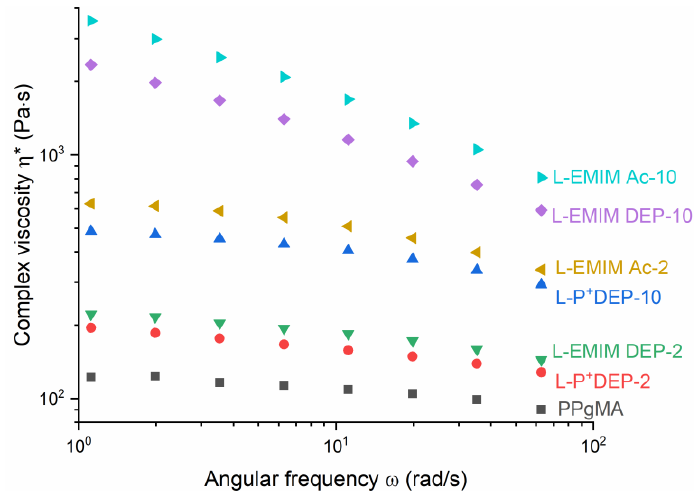
Figure 6. Complex viscosity of neat PPgMA and LIonomers as a function of the dynamic angular frequency at 180 ◦